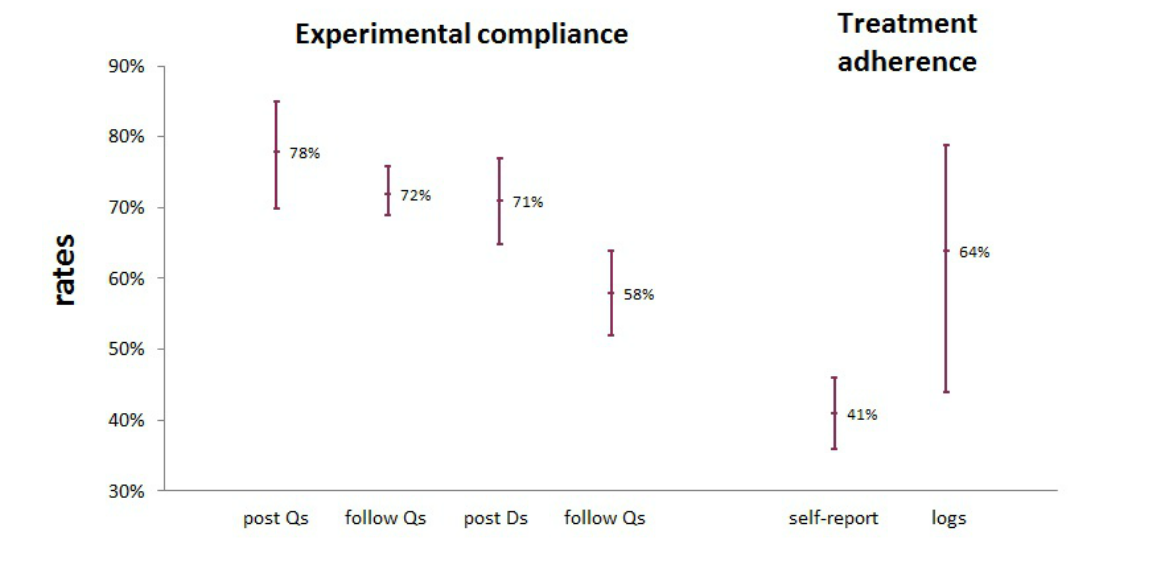
Figure 3. Mean compliance and adherence rates and their 95% CIs. post: posttreatment measurement; follow: follow-up measurement; Qs: questionnaires; Ds: diaries; self-report: self-reported adherence with questions; logs: automatically logged behavior.